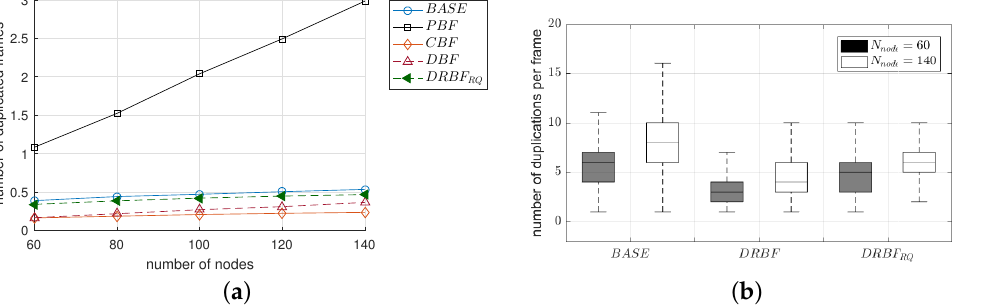
Figure 11. The performance comparison of the flooding mechanisms in terms of ( a ) the number of duplicate frames ( F dup ) and ( b ) the distribution of number of the duplications in all of the